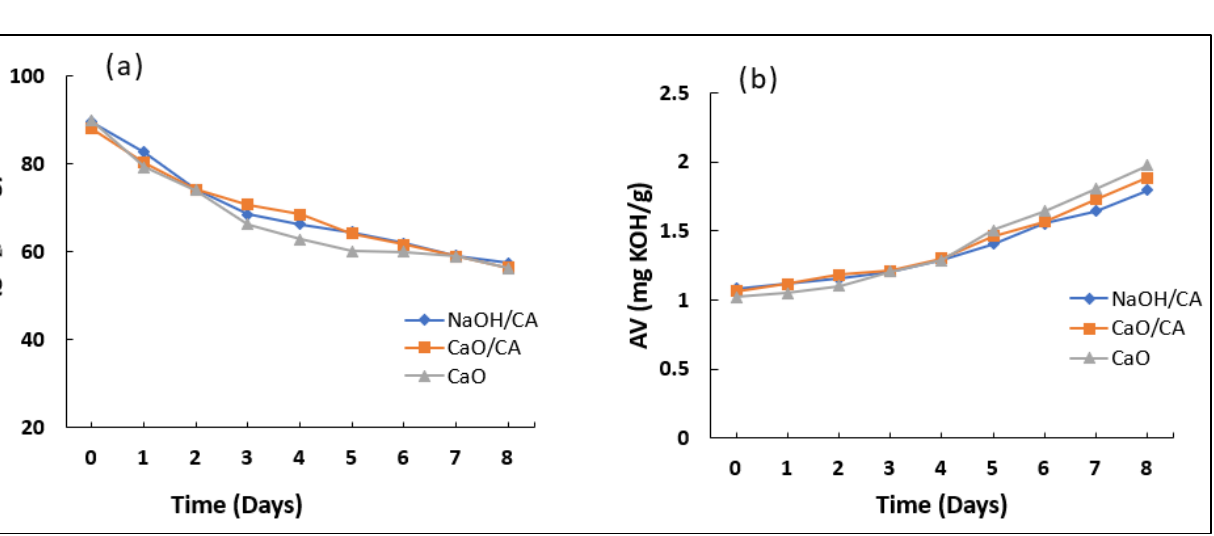
Figure 7. Results of the accelerated storage stability of B100: ( a ) iodine value and ( b ) acid